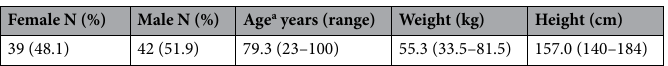
Table 1. Demographic data of cadavers. a Age at death.